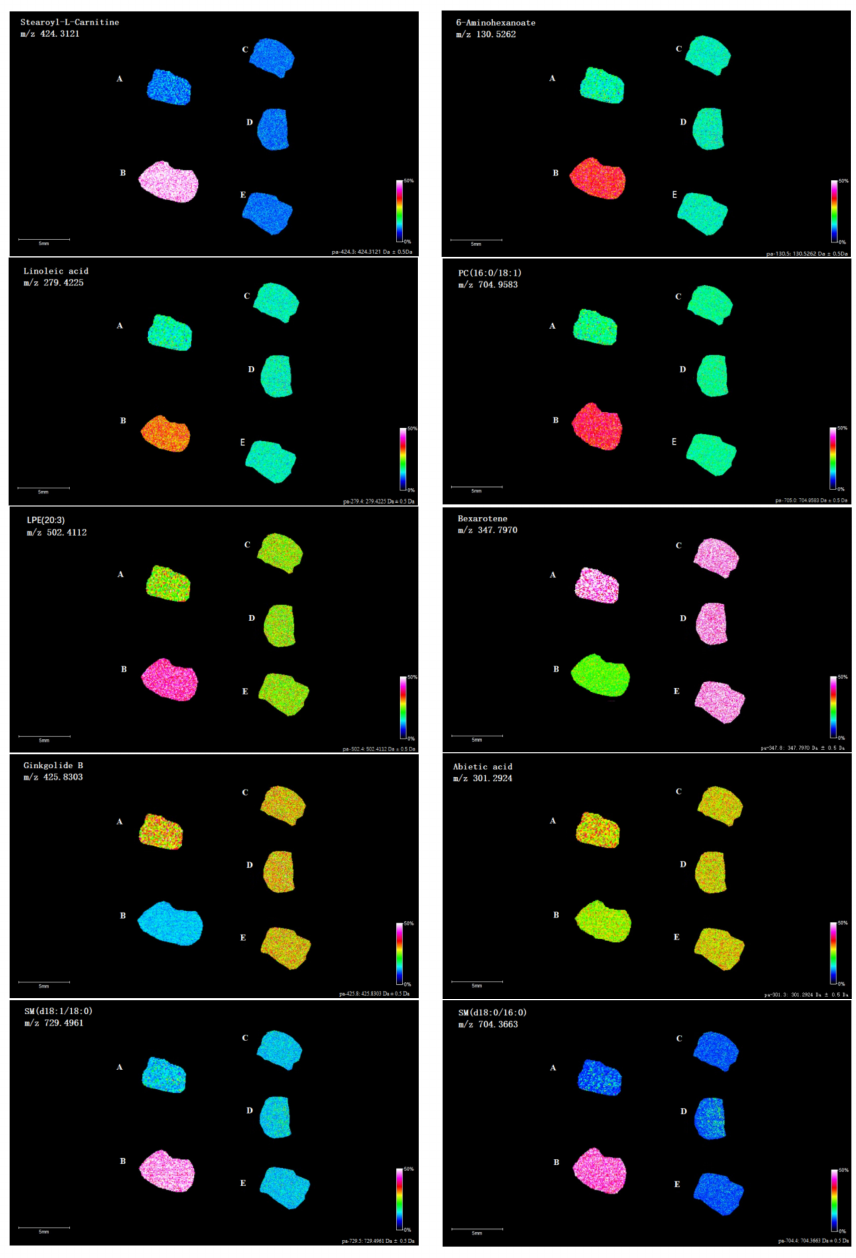
Figure 8. Mass spectrometry images of the 10 different lipids in the livers of mice (A–E were BCG, MCG, PLG, PMG and PHG groups,